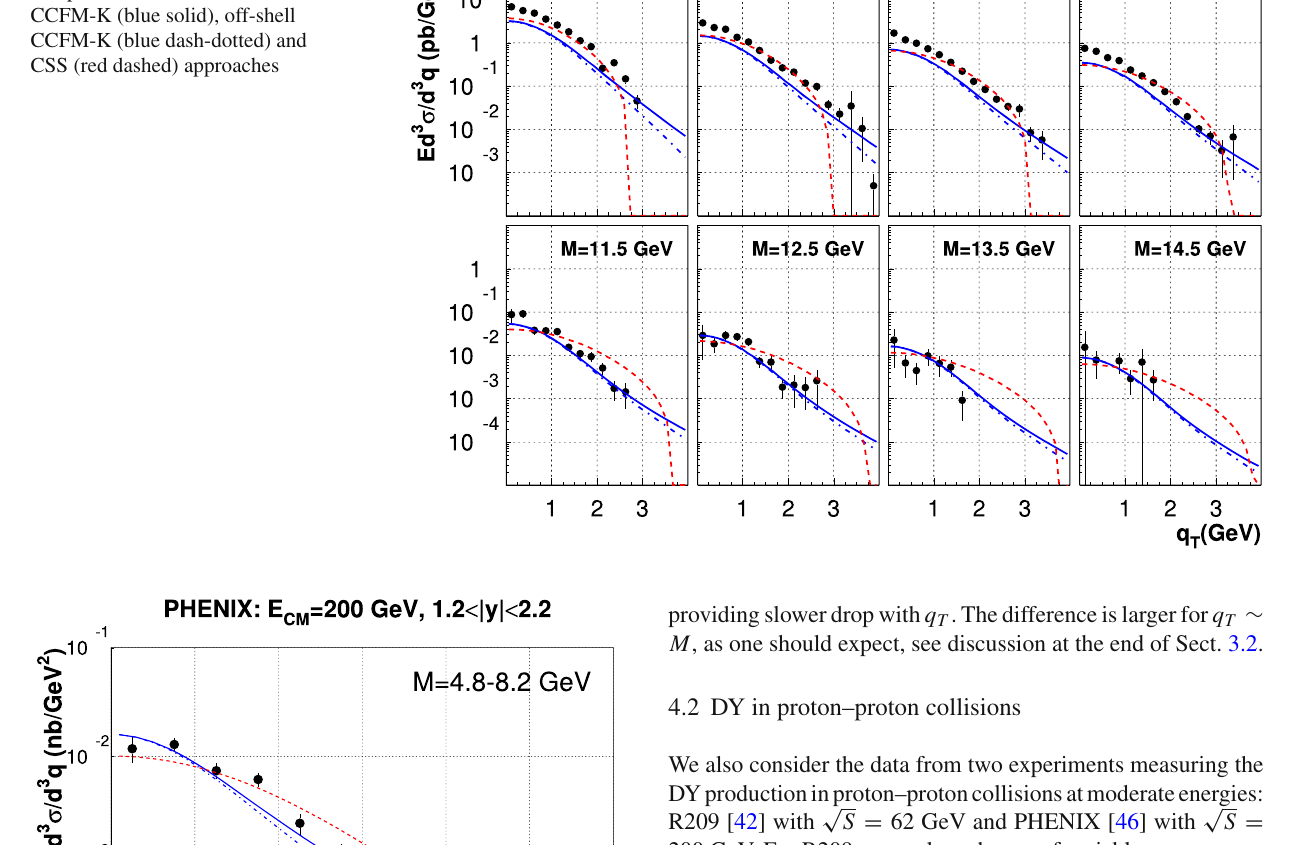
Fig. 8 Transverse momentum dependence of DY cross-section: data from fixed target experiment E772 [40] are compared with on-shell CSS (red dashed) approaches